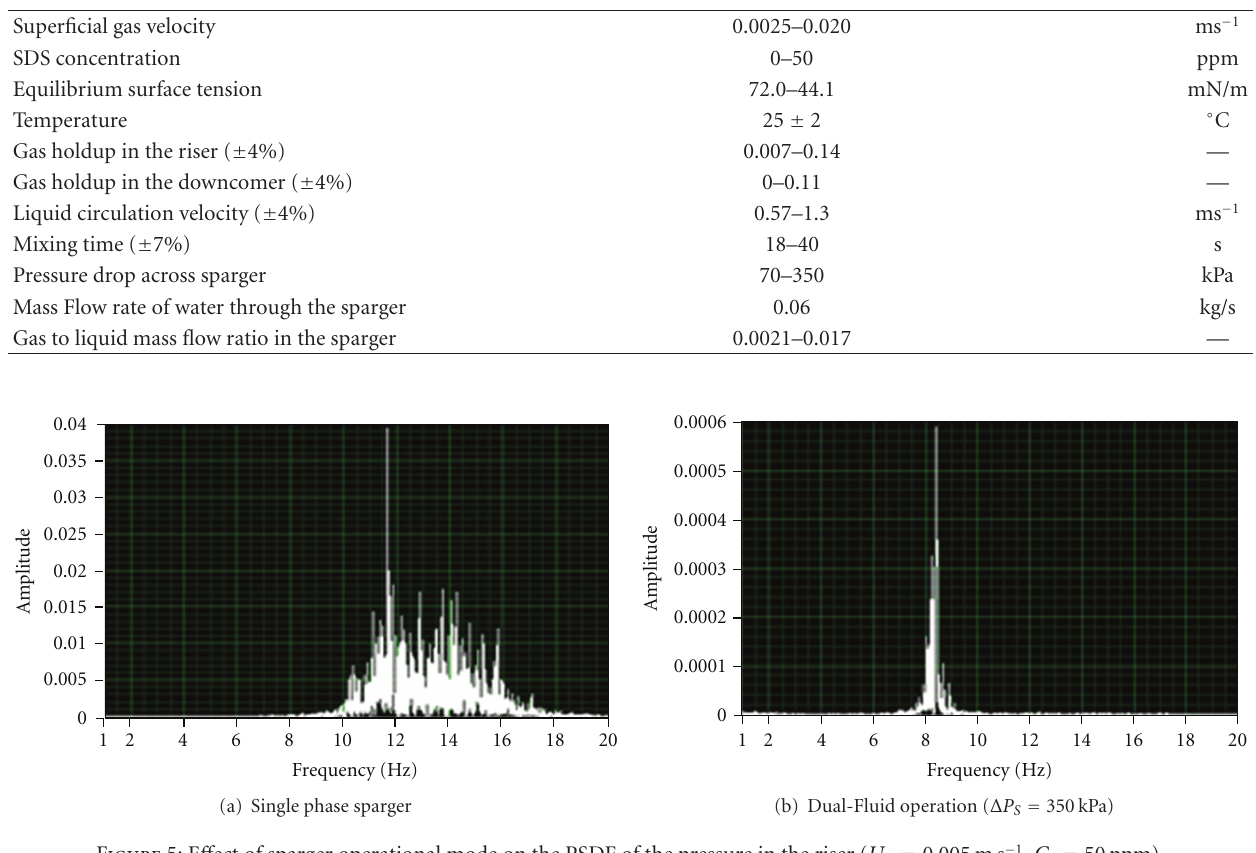
Figure 5: E ff ect of sparger operational mode on the PSDF of the pressure in the riser ( U G = 0 . 005 ms − 1 , C S =